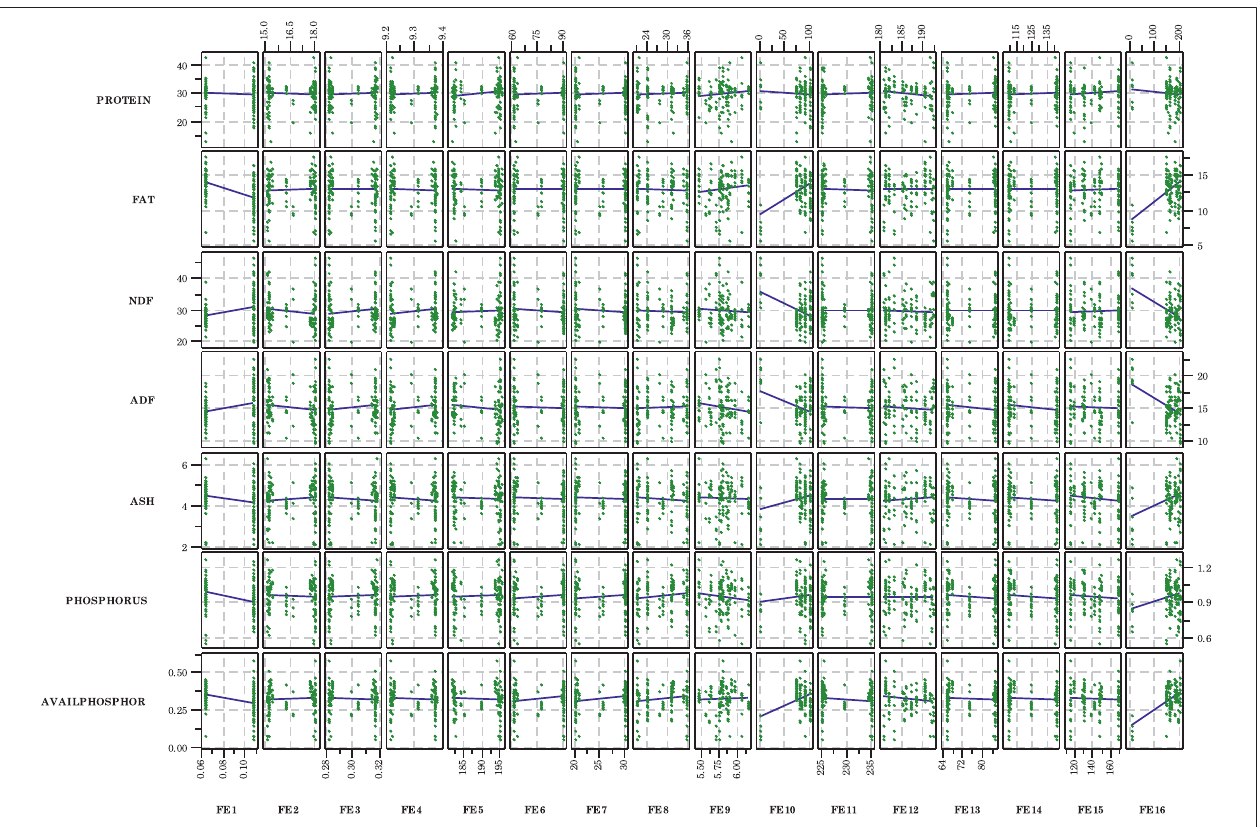
FIGURE 1 | Scatterplots of compositional variables for each front end independent variable. Although considerable scatter is present, some linear trends appear pronounced. Variable de fi nitions provided in Tables 1, 2 .